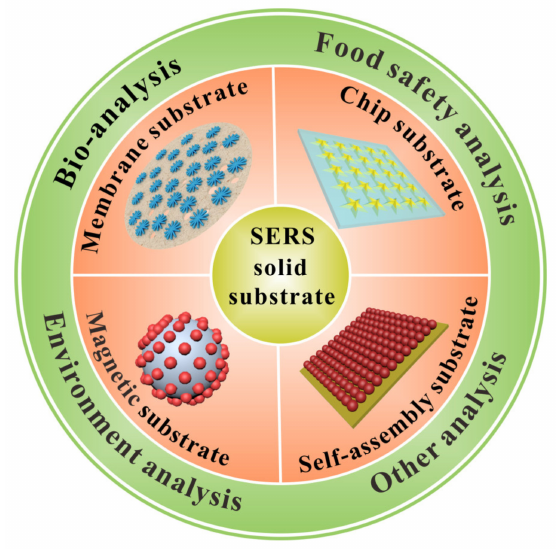
Figure 1. Various solid SERS substrates employed in analytical